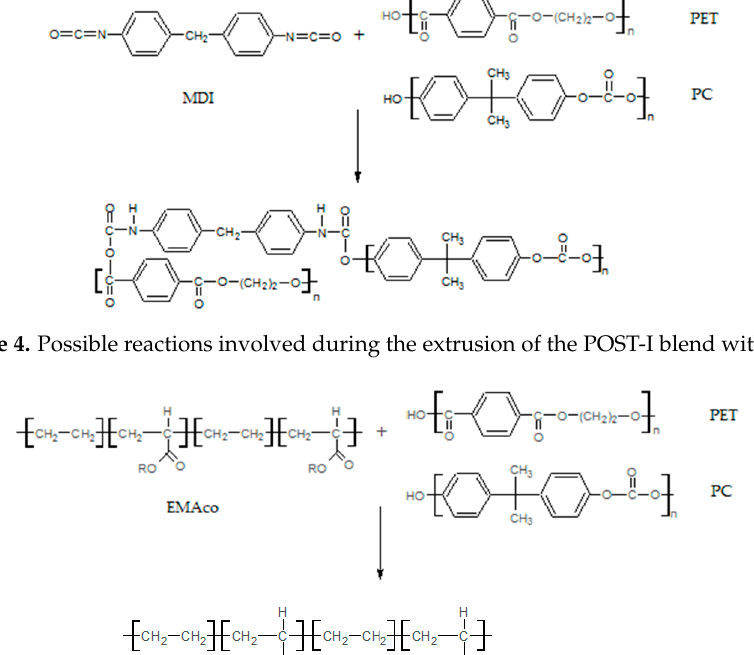
Figure 3. Possible reactions involved during the extrusion of the POST-I blend with ESAo.